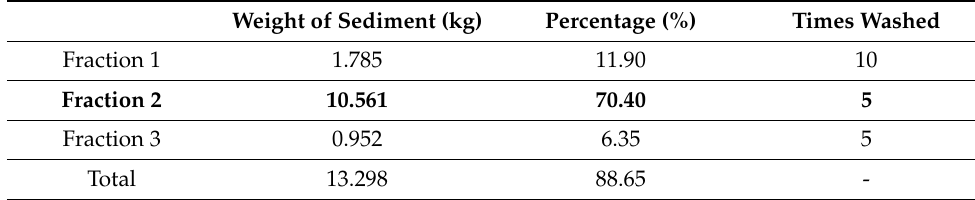
Figure 4. Fractionation of diatomite: I—5-fold sedimentation, 2 h each time; II—5-fold sedimentation, 1 h each time. Table 2. The weight of sediments obtained.